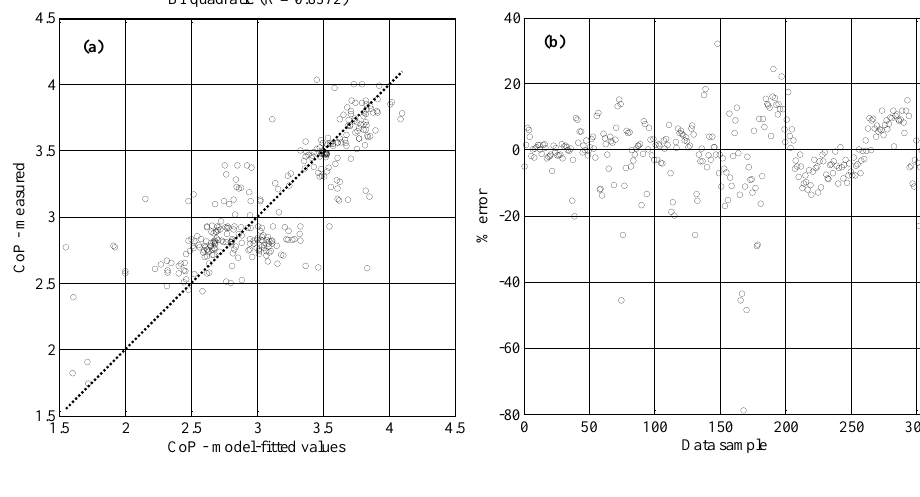
Table 2. Fitted coefficients for the heat pump